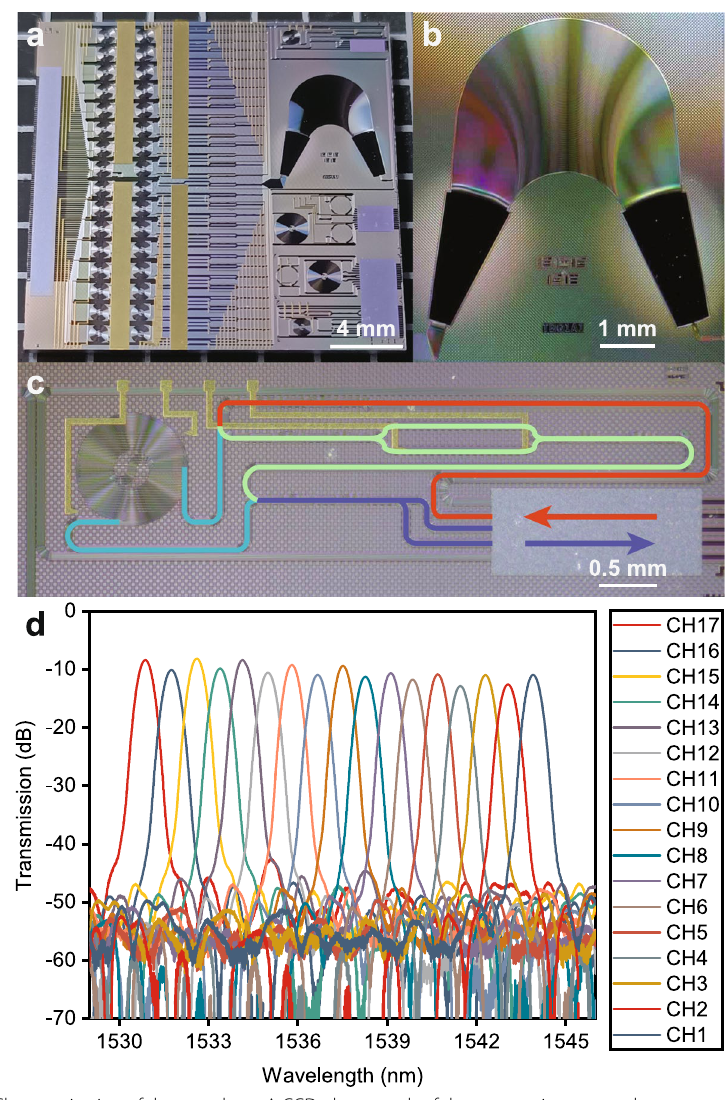
Fig. 2 Characterization of the samples. a A CCD photograph of the energy‑time entanglement preparation chip, composed of a 32‑channel AWG, 32 balanced MZIs and 32 UMZIs, 64 on‑chip heaters, coupled with a 128‑channel fiber array. b-c Microscope images of the AWG and UMZI. d Transmission of the 17 selected channels of the AWG, centered at C50 of international telecommunications union (ITU)